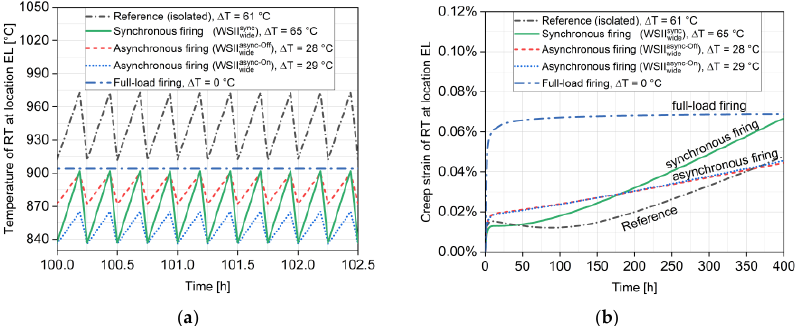
Figure 11. Results of burner firing operations: ( a ) temperature-time-cycle and ( b ) creep strain at location EL.